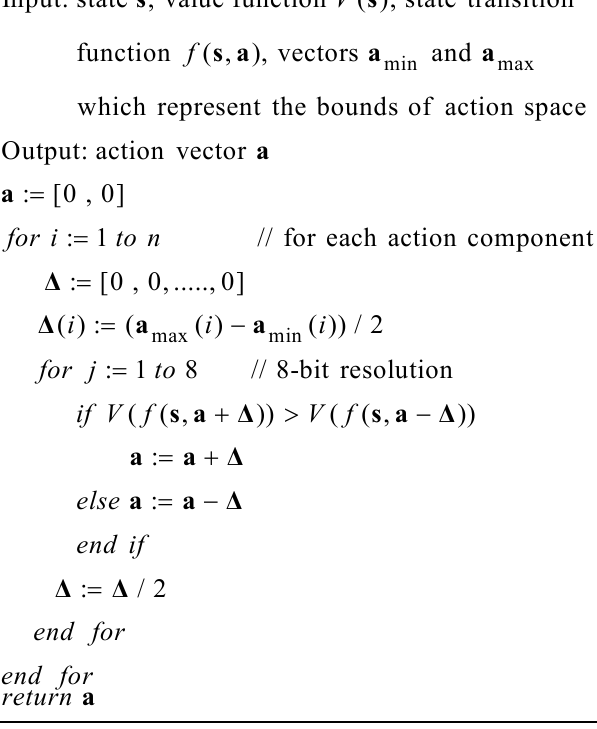
Figure 5. Continuous action search